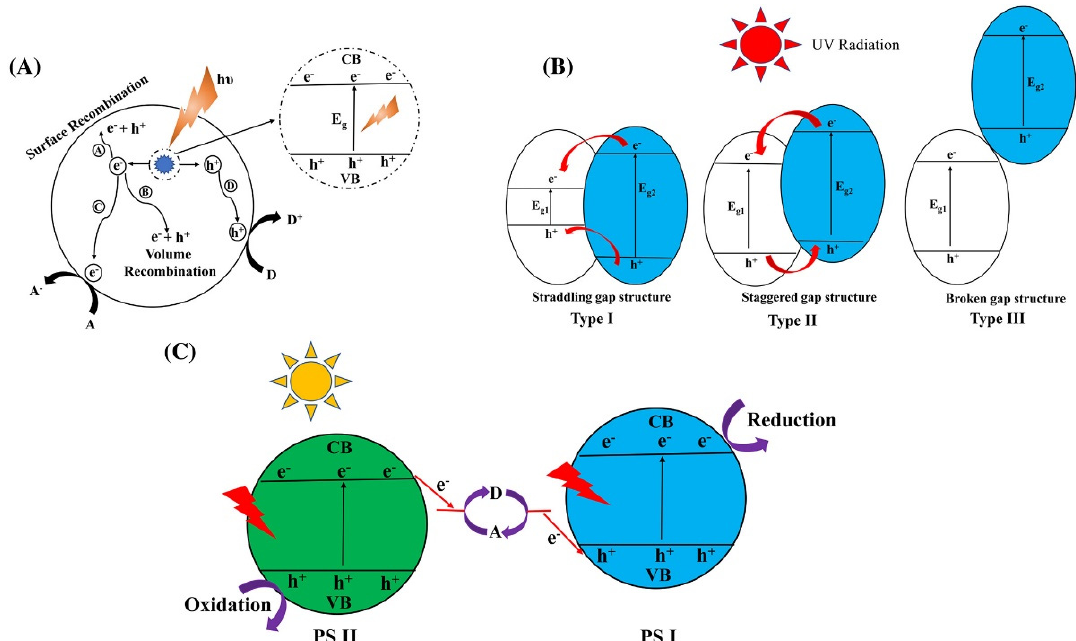
Figure 3. ( A ) Schematic illustration showing the electron-hole pathways in a photocatalytic process. ( B ) Schematic illustration showing three different types of semiconductor heterojunctions for photo- generated charge separation. ( C ) Schematic illustration of a Z-scheme photocatalytic system under light illumination [6,28,29]. Source A reprinted with permission from ref [28]: Copyright 1995 American Chemical Society [28]. B, C reprinted with permission from ref [29]: Copyright 2017, Jhon Wiley & Sons., Inc. [29].